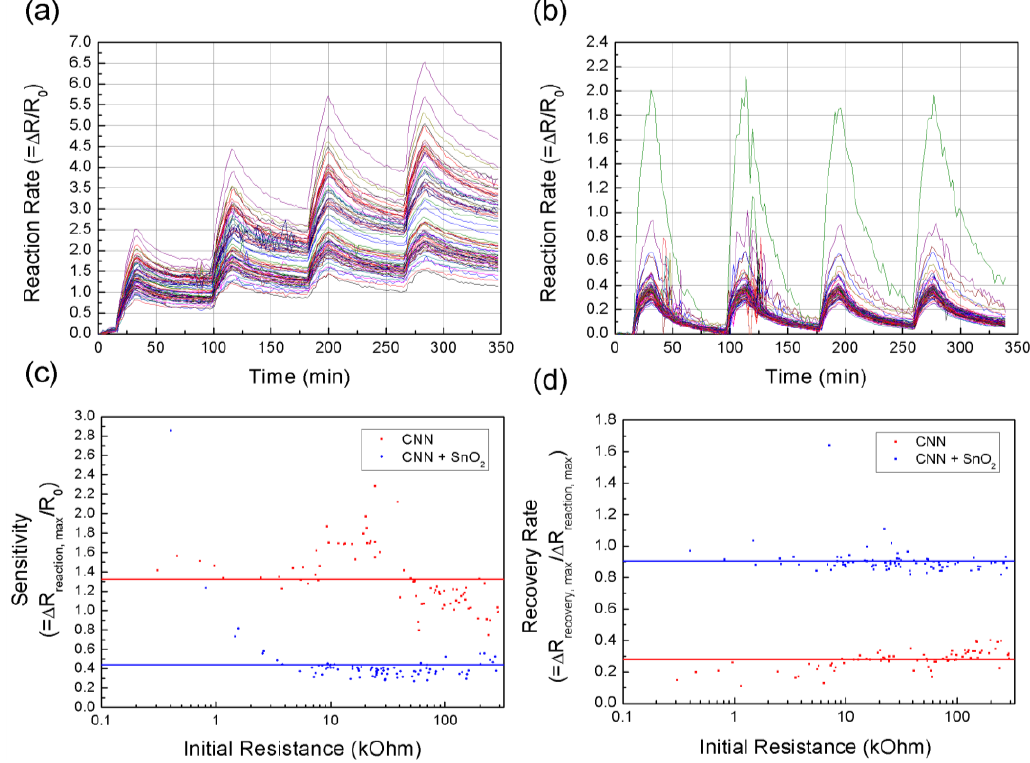
at 100 °C: 3 network cells to 1,000 ppm 2 network cells. ( d ) Distribution of the 2 network 2